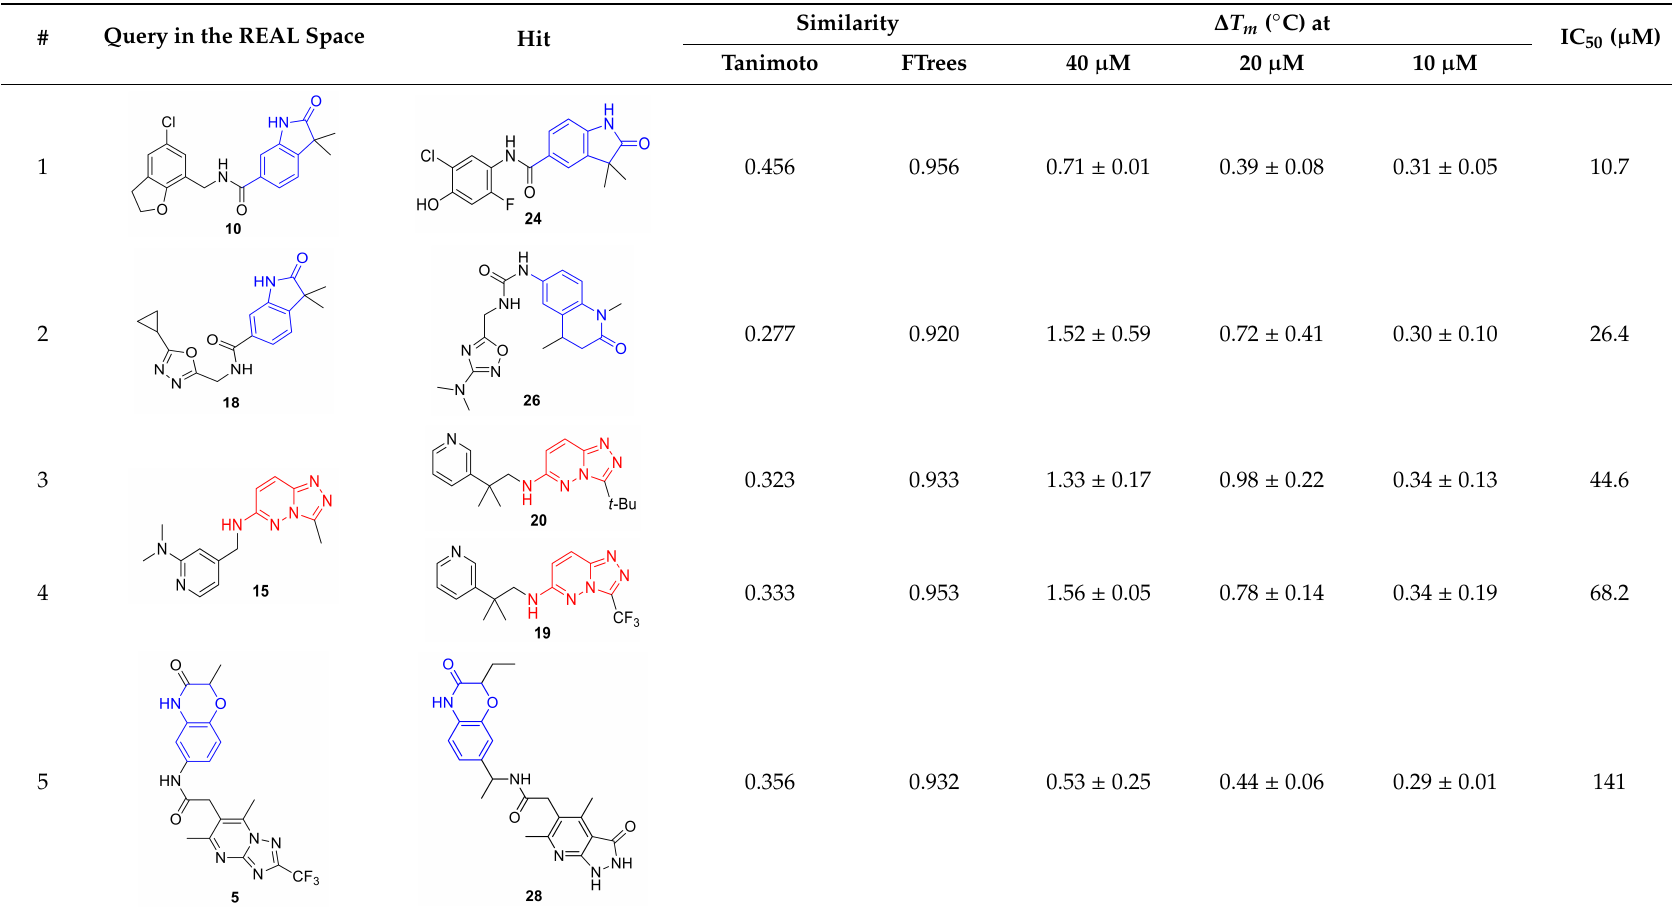
Table 1. Most active BRD4 inhibitors identified after TR-FRET (time-resolved fluorescence energy transfer)